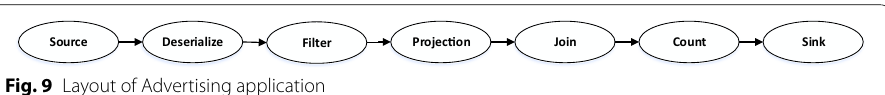
Fig. 9 Layout of Advertising